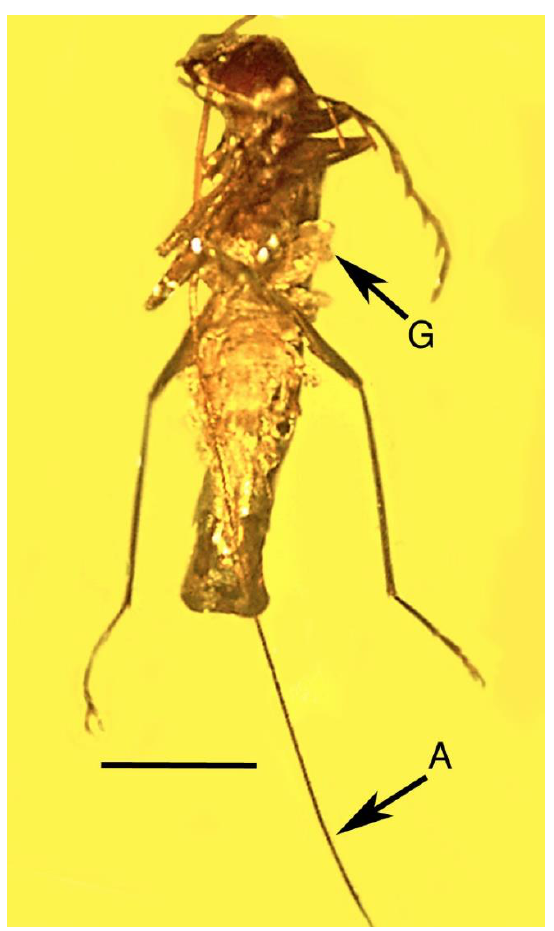
Figure 21. Soldier beetle (Coleoptera: Cantharidae) displaying chemical defense behavior in Burmese amber. G = extruded glandular vesicle. A = antenna of predatory blattid (Blattodea: Blattidae) in contact with the beetle. Scale bar = 1.2 mm.